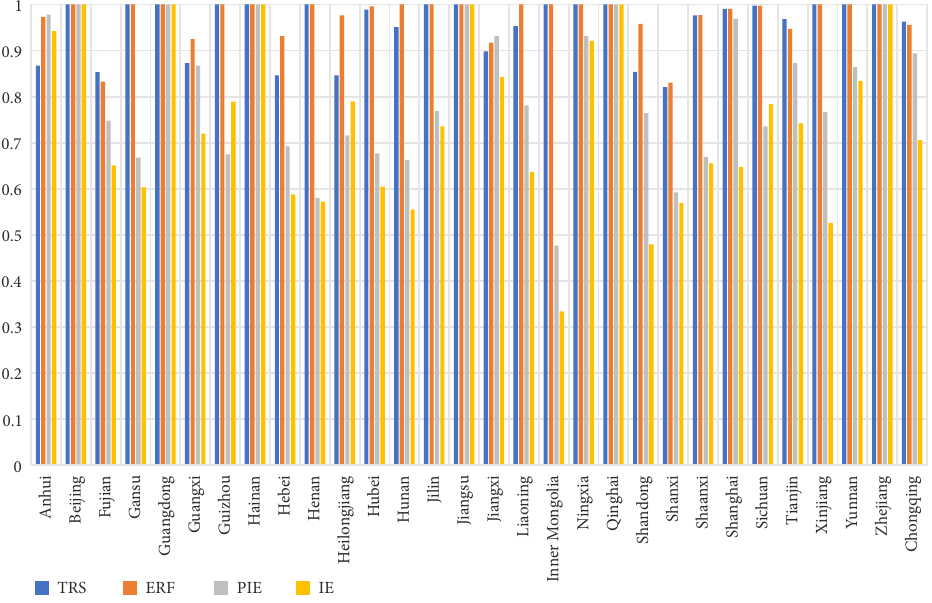
Figure 6. Average input efficiency by